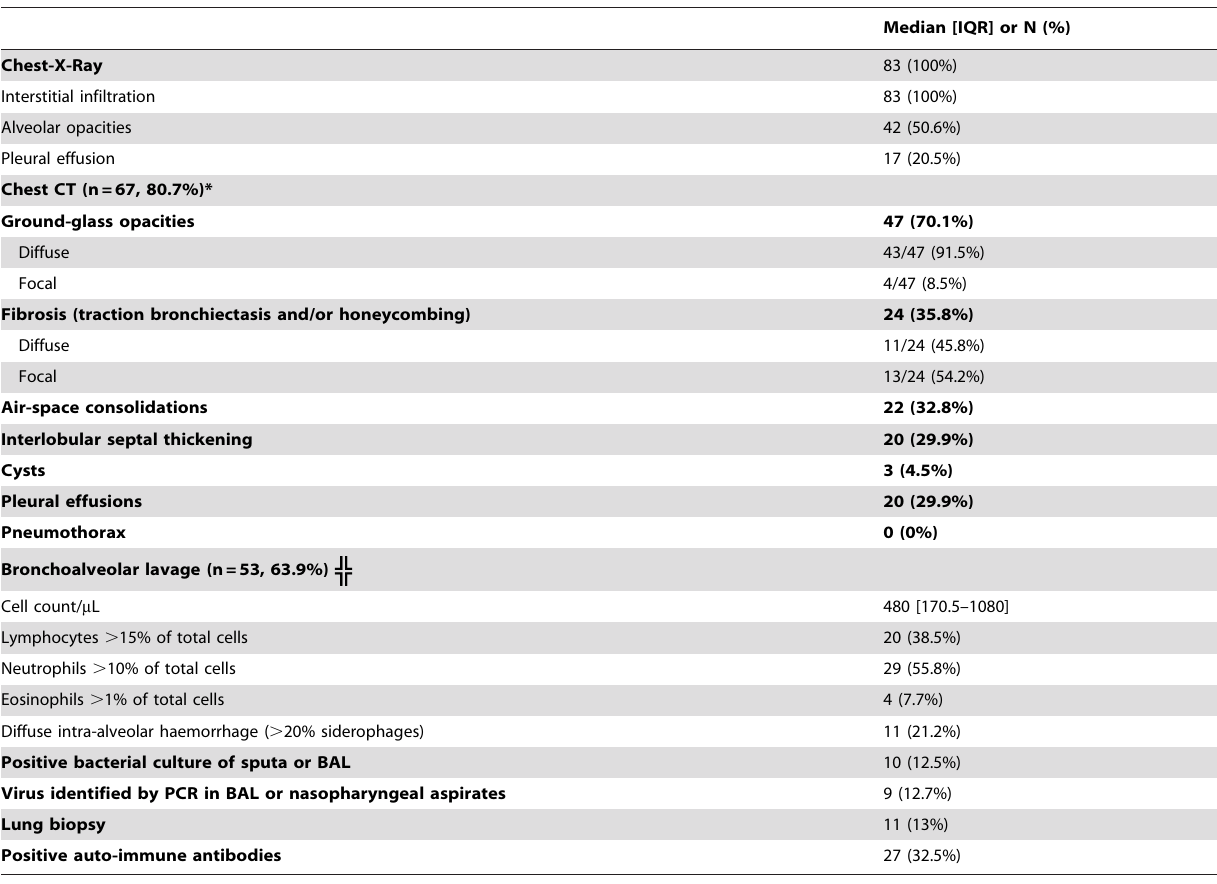
Table 3. Diagnostic